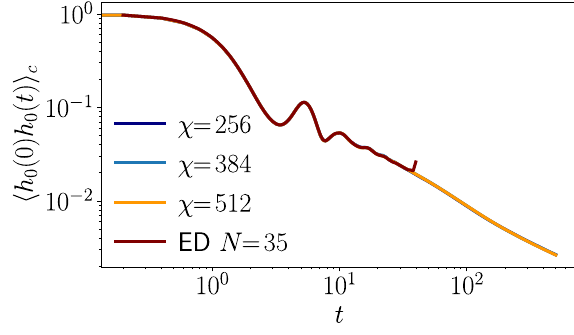
FIG. 6. Comparing the PXP model results for different bond dimensions χ ∈ f 256 ; 384 ; 512 g against the ED result for system size N ¼ 35 . We observe that all bond dimensions give nearly identical results with relative errors between consecutive bond dimensions at most